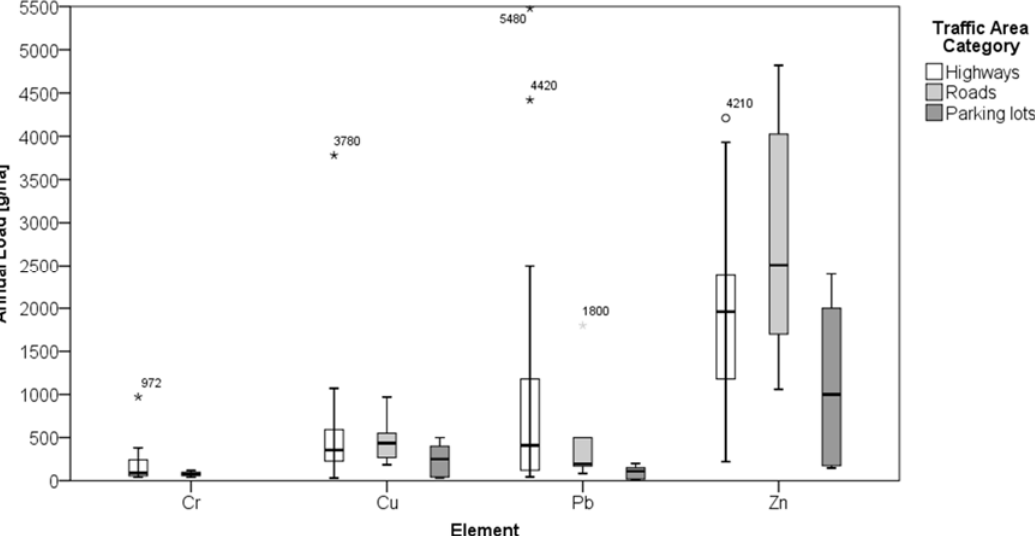
Figure 1. Annual total heavy metal loads of Cr ( n = 10), Cu ( n = 41), Pb ( n = 42), and Zn ( n = 43)